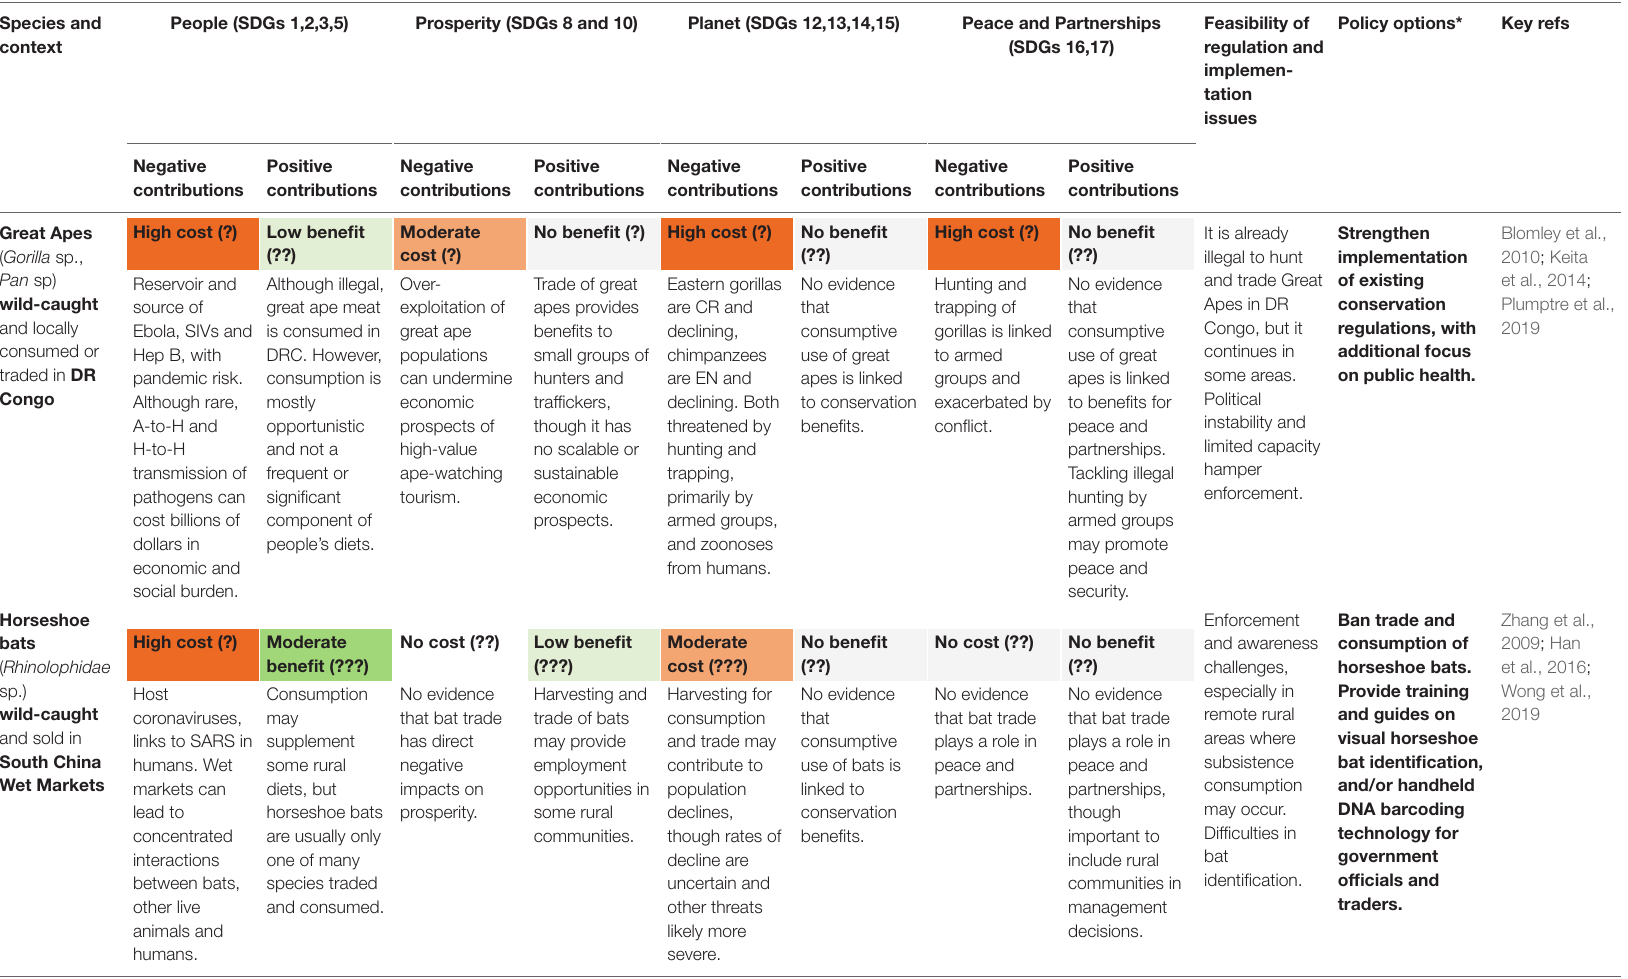
TABLE 1 | Evaluating the diverse costs and benefits of wildlife trade across the SDGs: six case study examples. Species and